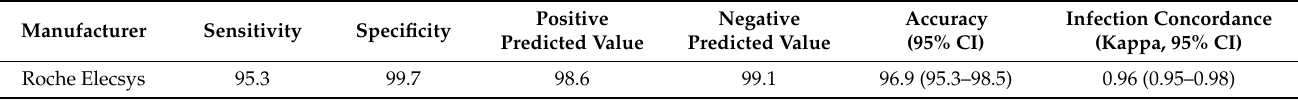
Table 5. Roche Elecsys ® immunoassay performed to diagnose SARS-CoV-2 infection in the validation cohort ( n =